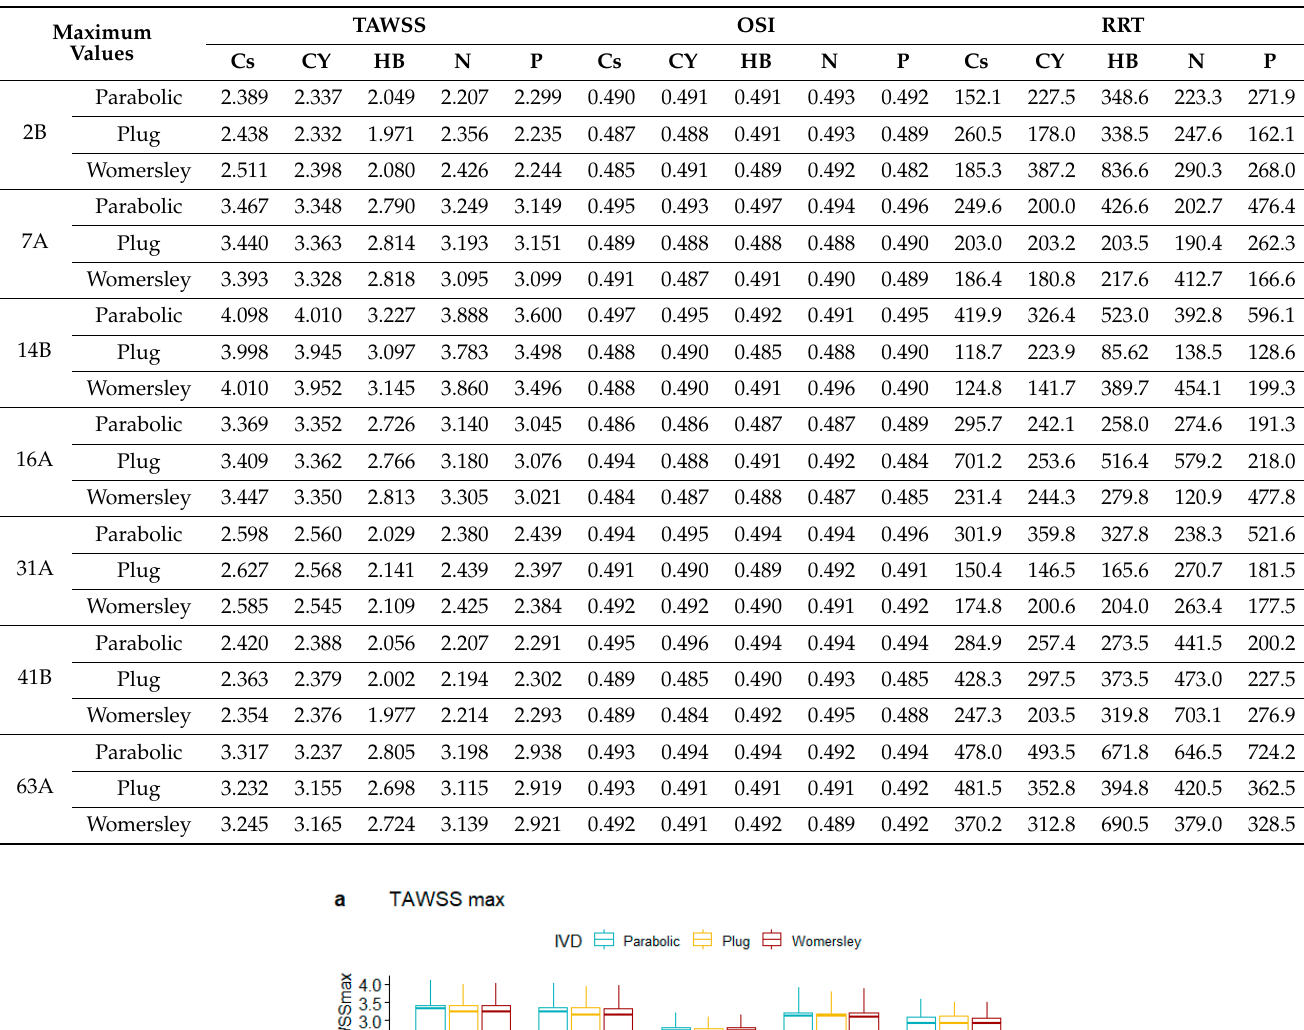
Table 8. Maximum values and TAWSS, OSI, and RRT.